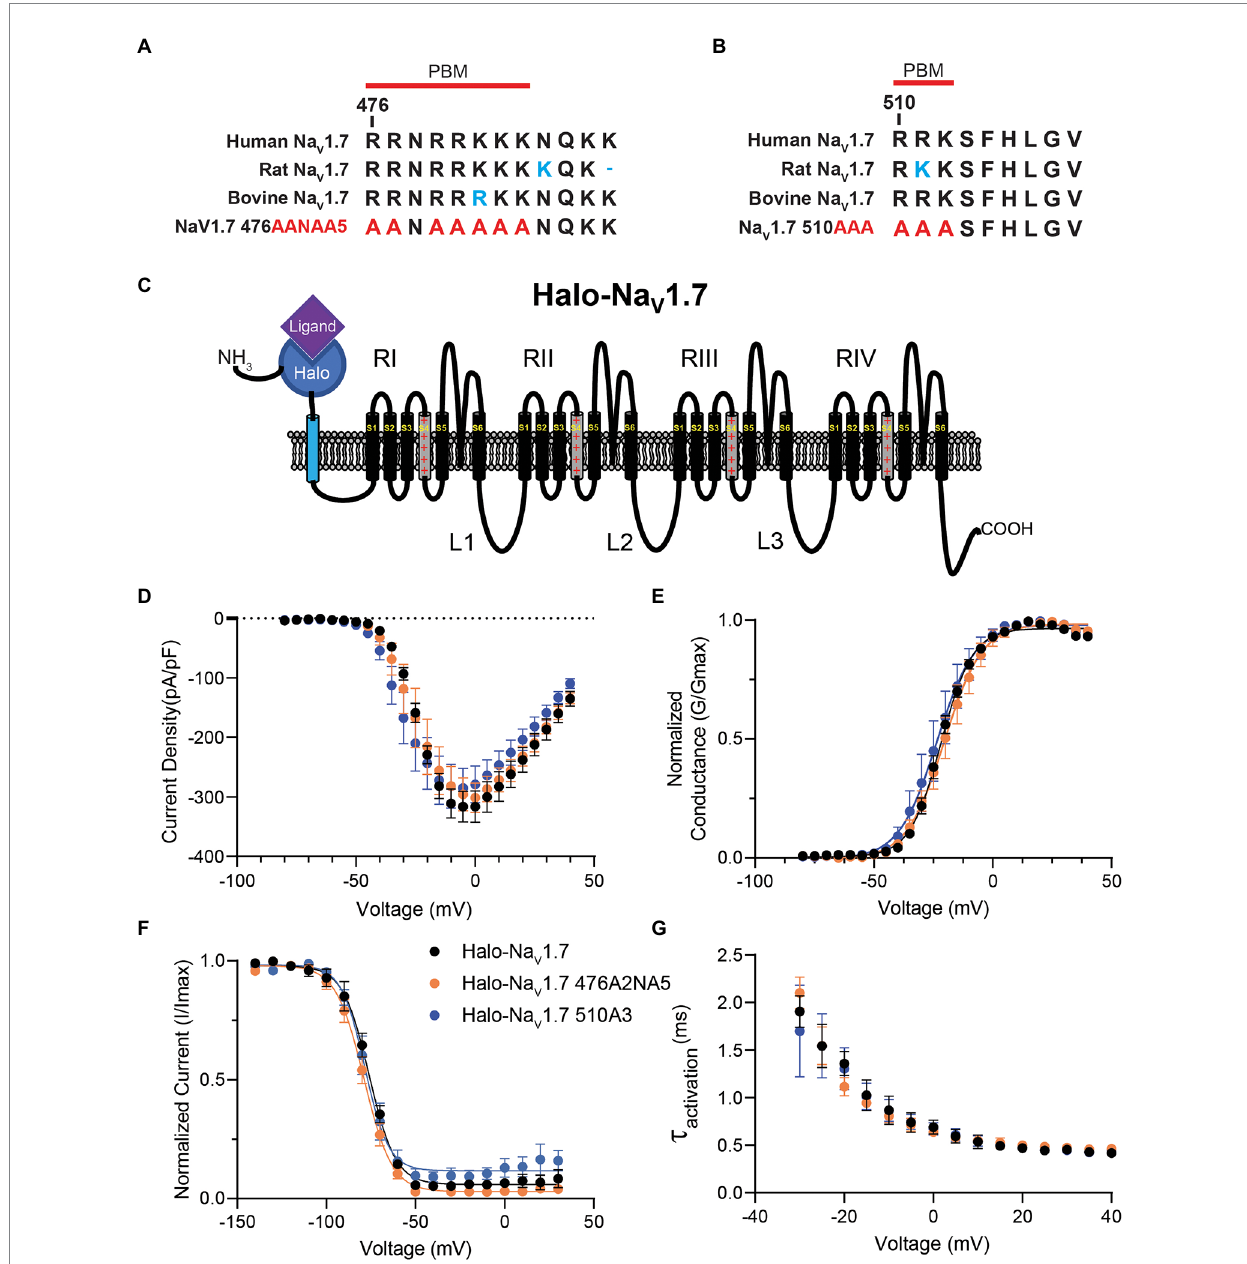
FIGURE 1 Sequence comparison and electrophysiologic characterization of the polybasic amino acid motifs in Na V 1.7 loop 1. (A) Sequence alignment of Amino Acids 476–487 in loop 1 of Na V 1.7 between human Na V 1.7 (accession no. Q15858), rat Na V 1.7 (accession no. O08562), bovine Na V 1.7 (accession no. M0QVY7) and the mutant human Na V 1.7 with alanine substitutions for basic residues at positions 476–477 and 479– 483. Red line marks the definition of the polybasic motif beginning at position 476. (B) Sequence alignment of Amino Acids 510–518 in loop 1 of Na V 1.7 between human Na V 1.7 (accession no. Q15858), rat Na V 1.7 (accession no. O08562), bovine Na V 1.7 (accession no. M0QVY7) and the mutant human Na V 1.7 with alanine substitutions for basic residues at positions 510–512. Red line marks the definition of the polybasic motif beginning at position 510. (C) Schematic of the Halo-Na V 1.7 construct used in our experiments. The channel features the Halo-tag enzyme fused to the extracellular N-terminus of the channel via an extra transmembrane linker. (D) HEK293 cells were co- transfected with either Halo-Na V 1.7, Halo-Na V 1.7 476A2NA5, or Halo-Na V 1.7 510A3 and GFP. Positively transfected cells were identified by fluorescence and analyzed by whole-cell voltage-clamp. Current–voltage relationships for currents produced by Halo-Na V 1.7 ( n = 10), Halo- Na V 1.7 476A2NA5 ( n = 10), or Halo-Na V 1.7 510A3 ( n = 10). (E) Conductance values were generated by equation 2, normalized to the maximum conductance and fit with equation 3 (Supplementary Material). Half-activation values were similar between the three constructs ( p = 0.41). (F) Fast inactivation relationships for Halo-Na V 1.7 ( n = 8), Halo-Na V 1.7 476A2NA5 ( n = 7), or Halo-Na V 1.7 510A3 ( n = 7) were fit with by equation 3 (Supplementary Material). Half-inactivation values were similar between the three constructs ( p = 0.40). (G) Activation kinetics for the